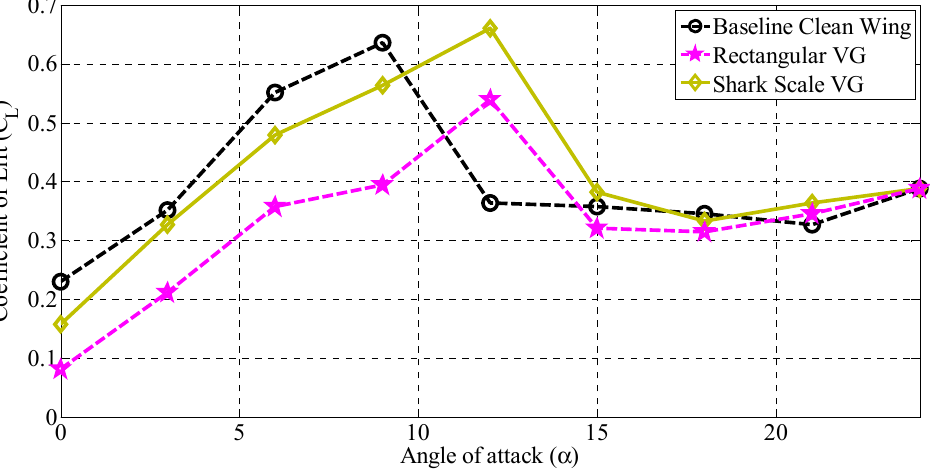
Figure 7. Coefficient of lift ( C L ) vs. angle of attack ( α ) for baseline and modified model with shark scale vortex generators (SSVG).